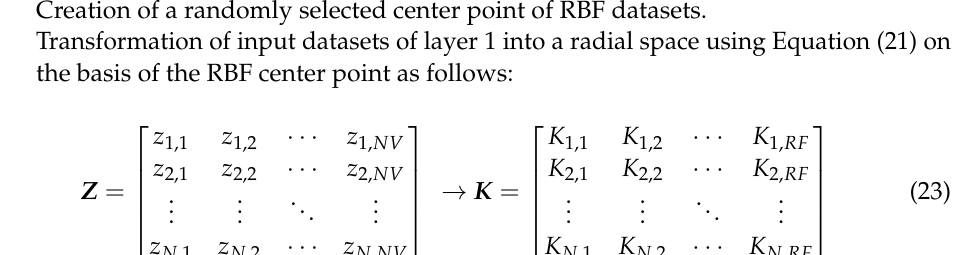
Figure 7. Schematic diagram of a radial basis function transformation ( K ) for C = 0 and ε = 0.5. Figure 8 represents the schematic diagram of an RM5 tree model with three layers, namely, input, transfer and calibration. In the input layer, input datasets are normalized using Equation (21). The following steps are involved in transferring RBF datasets to the second